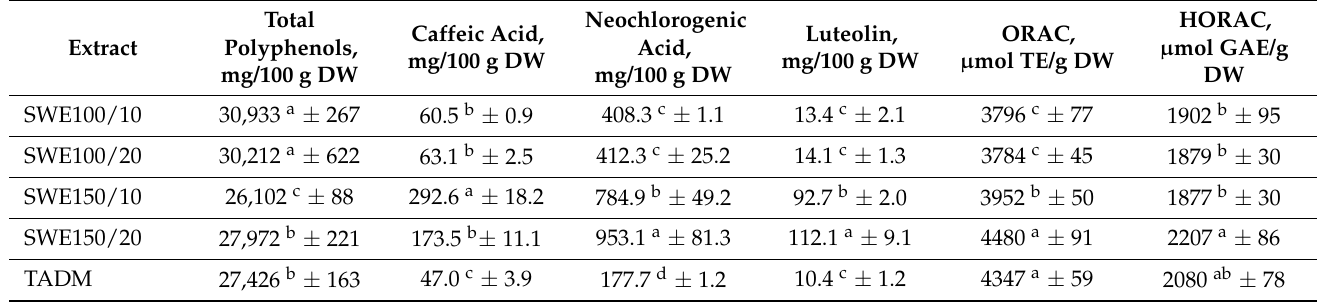
Table 2. Content of total and individual phenolics and antioxidant activity of freeze-dried lemon balm extracts, obtained by different extraction